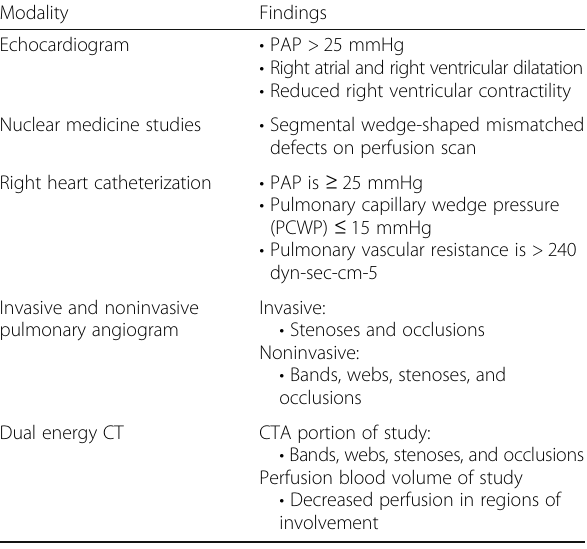
Table 2 Imaging findings in CTEPH. (PAP = pulmonary artery pressure, PCWP = pulmonary capillary wedge